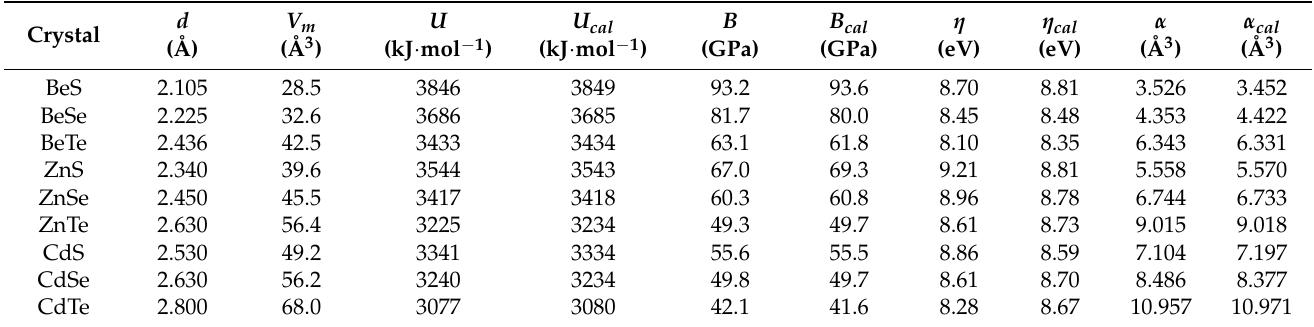
Table 3. Chemical bond length d , molar volume V m , lattice energy U , calculated lattice energy U cal , bulk modulus B and calculated bulk modulus B cal , chemical hardness η , calculated chemical